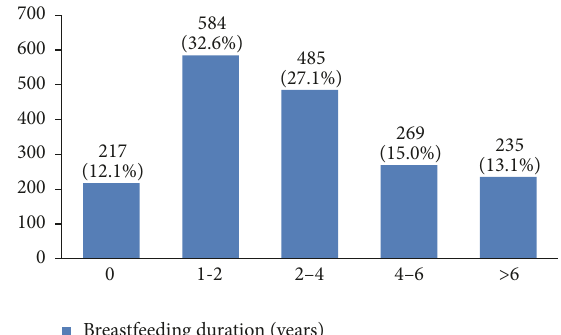
Figure 5: The gravidity of the studied breast cancer cases.